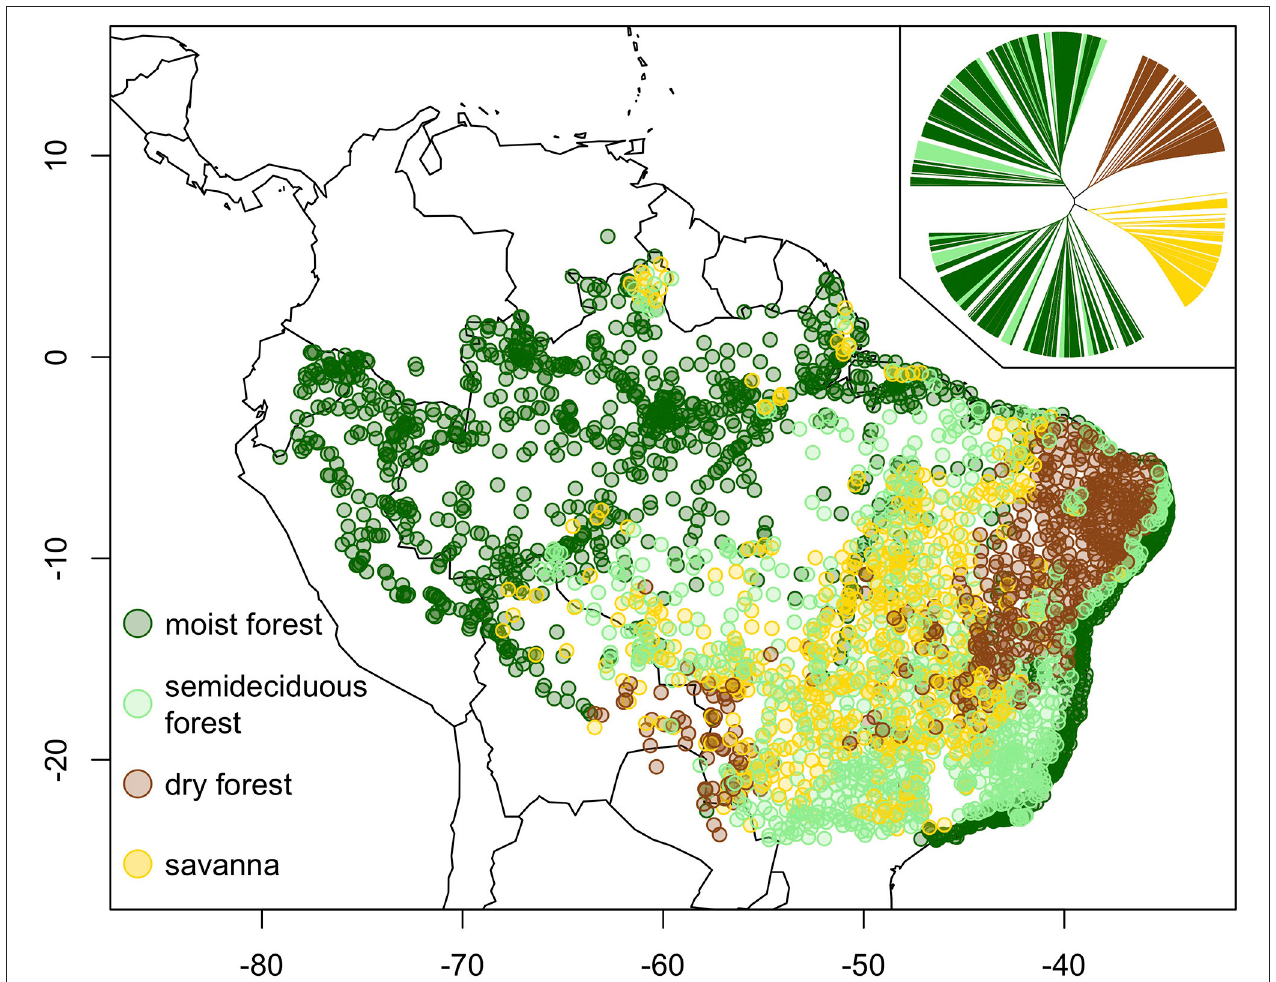
FIGURE 1 | Map of biomes across lowland tropical South America (after Silva de Miranda et al., in press). Inset shows results of unsupervised clustering of 3,331 georeferenced sites based on tree species composition. The biomes of the major groups in the cluster were determined based on vegetation physiognomy and leaf flush regime. Semideciduous forests were placed in the moist forest biome based on similarities in tree species composition evident in the cluster by Silva de Miranda et al. (in press) , but are distinguished here. We exclude sites south of 23 ◦ S latitude or above 1,000m